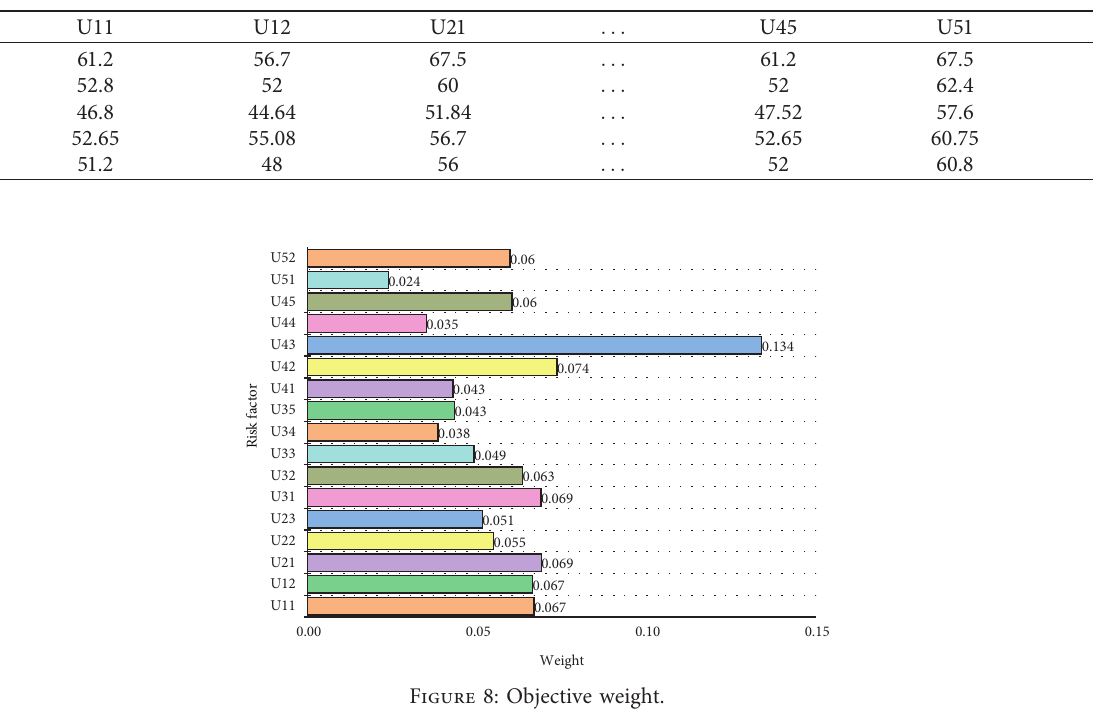
Table 7: Initial decision matrix.